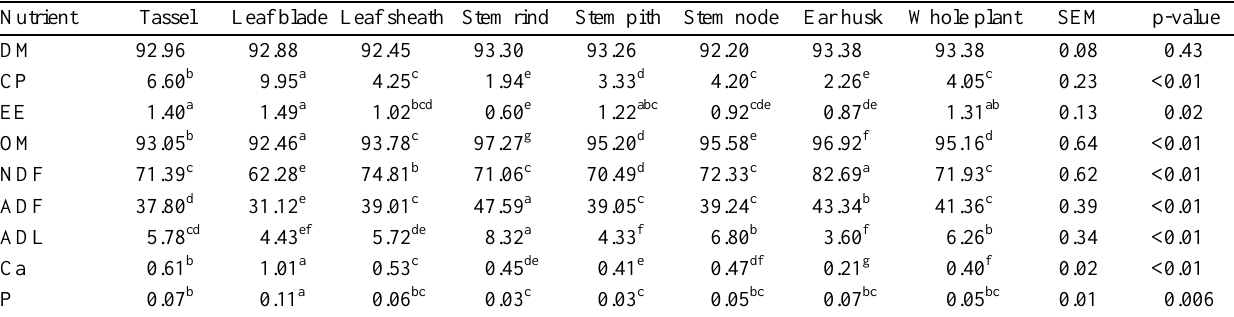
Table 1. Chemical composition of whole corn stover and different morphological fractions (%, air-dry basis) Nutrient Tassel